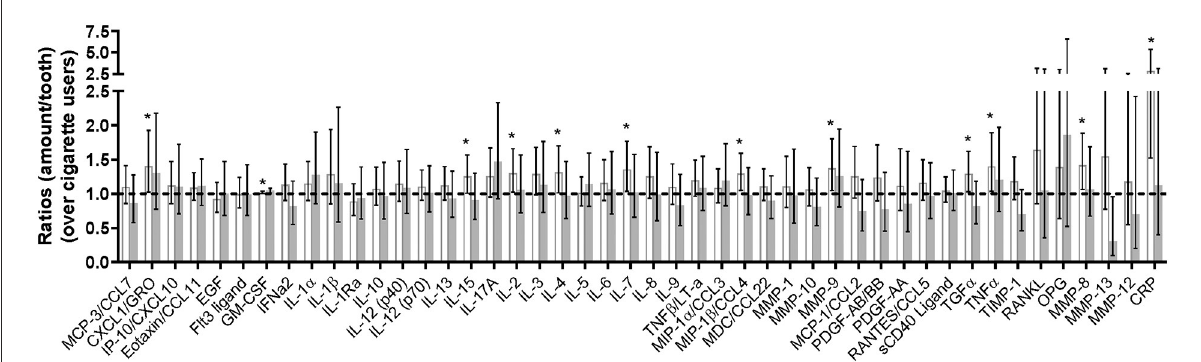
FIGURE4 Changes in multiplex assay- and parallel reaction monitoring-analyzed inflammatory mediators (As Exposed Set). Bars represent the ratio of geometric means between THS users, dual users and cigarette smokers (95% CI); white bars, IQOS users; gray bars, dual users; dotted line, levels for cigarette smokers. MCP-3/CCL7, chemokine (C-C motif) ligand 7 [pg/tooth]; CXCL1/GRO, chemokine (C-X-C motif) ligand 1 [pg/tooth]; IP-10/CXCL10, chemokine (C-X-C motif) ligand 10 [pg/tooth]; Eotaxin/CCL11; eotaxin-1 [pg/tooth]; EGF, epidermal growth factor [pg/tooth]; Flt3 ligand, fms-related tyrosine kinase 3 ligand [pg/tooth]; GM-CSF, granulocyte-macrophage colony-stimulating factor [pg/tooth]; IFN α 2, interferon alpha-2 [pg/tooth]; IL-1 α , interleukin-1 alpha [pg/tooth]; IL-1 β , interleukin-1 beta [pg/tooth]; IL-1Ra, interleukin-1 receptor